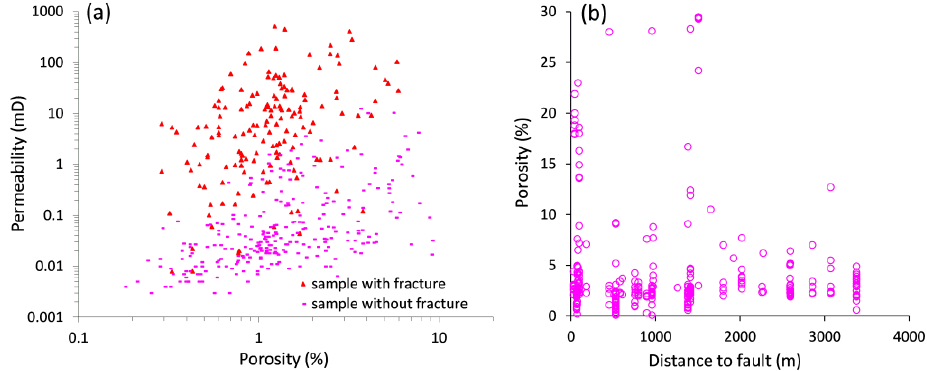
Figure 6. Porosity-permeability correlation from the core plugs ( a ) and average porosity of a well reservoir interval vs. distance to fault ( b ) by logging interpretation in the Ordovician reef-shoal reservoirs.